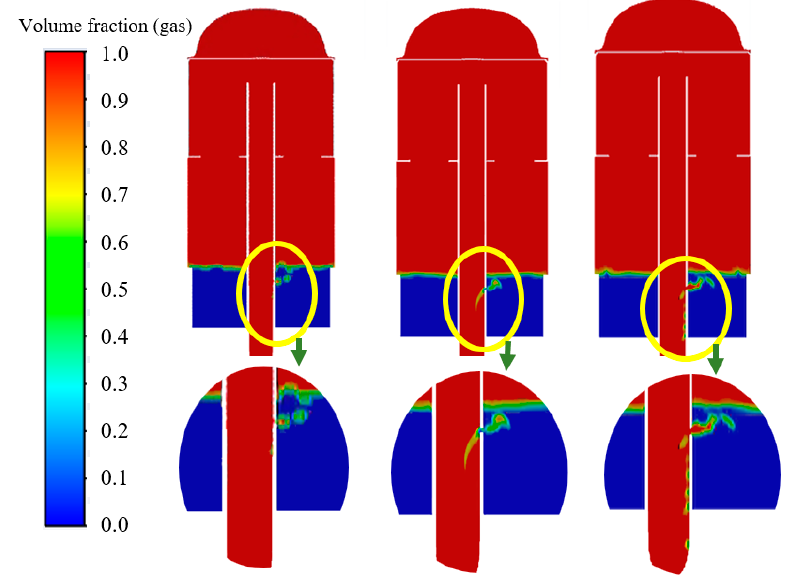
Figure 14. Liquid shape under the conditions of different liquid-return-hole diameters. D hole = 1 mm D hole = 1.5 mm D hole = 2 mm.